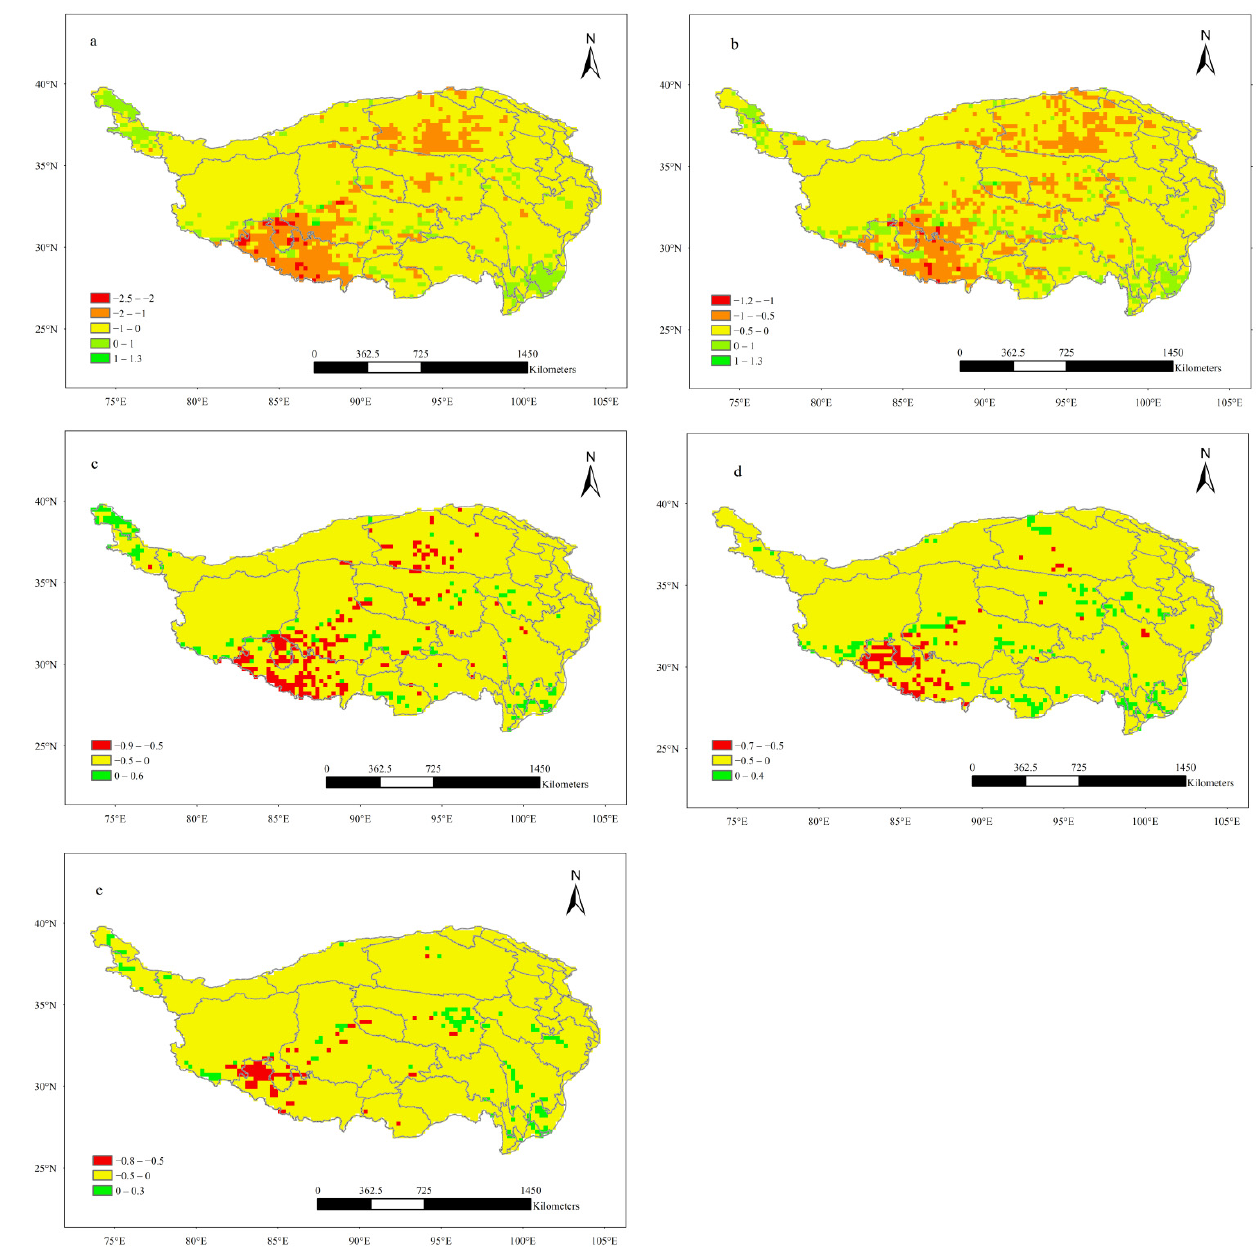
Figure 2. Spatial distribution of long-term variation trends for annual frequencies of different grades of snow disasters (( a – e ) represent total snow disasters, slight, moderate, heavy, and extremely heavy snow disasters, respectively).